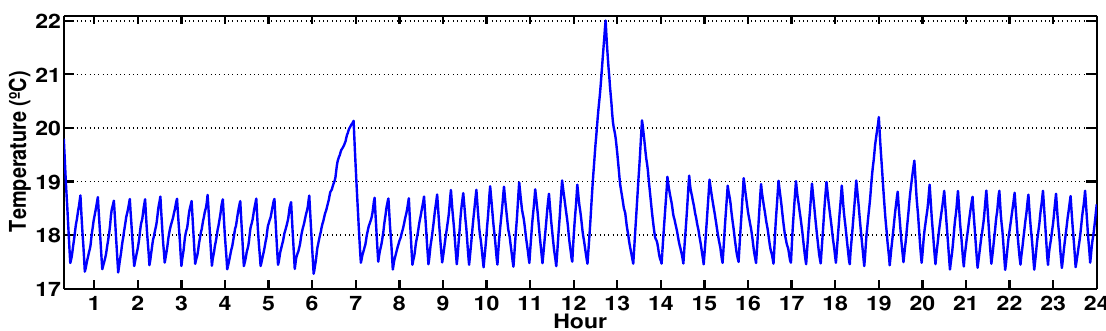
Figure 12. The room temperature without using smart plugs.